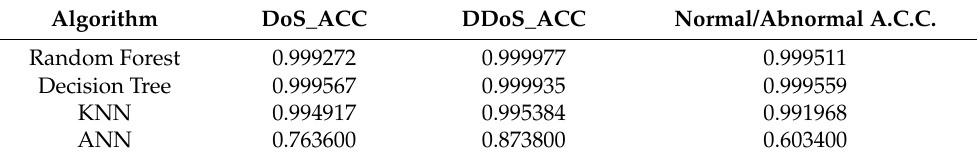
Table 6. Algorithm performances.